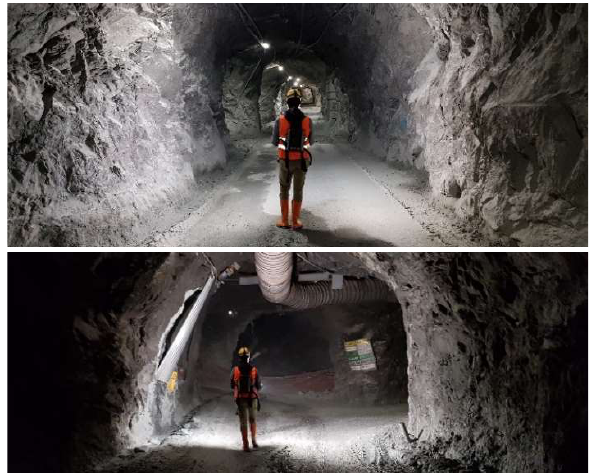
Figure 1 . Survey acquisition inside the IMI Fabi